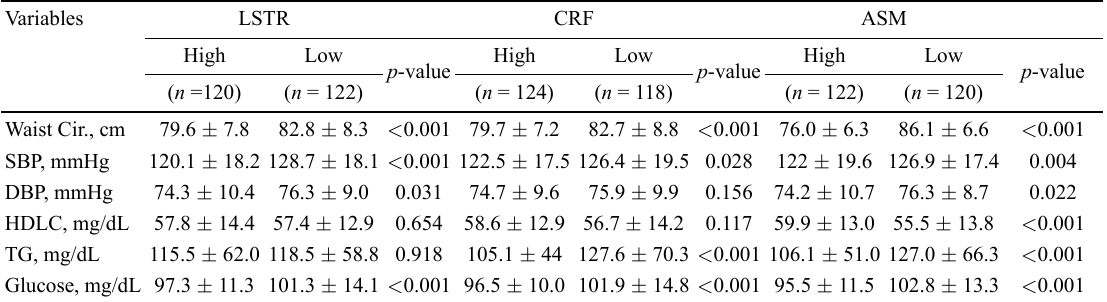
Table 3. Women’s metabolic syndrome factors based on relative values of variables. Variables